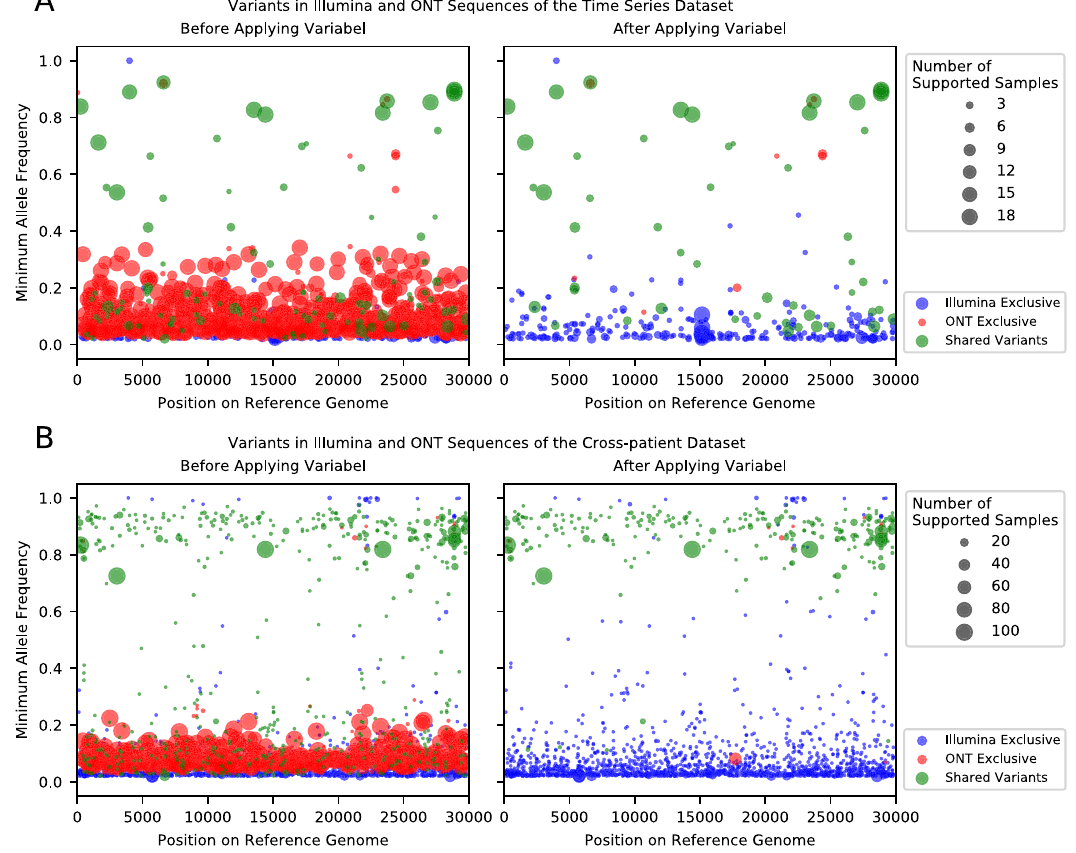
Fig. 2 Variants called by LoFreq with Illumina and ONT sequences before and after applying Variabel for COVID-19 datasets. In each of the sub fi gures, the left plot shows the variant calls before applying variabel and the right plot shows the variant calls after applying variabel. The x -axis shows the position of the variant on the reference genome. The y -axis shows the minimum allele frequency of the variant found in multiple samples. Variants found in the Illumina sequences only are marked in blue, and variants found in the ONT sequences only are marked in red. Variants that are shared between both Illumina and ONT data are shown in green. The size of the dot represents the number of samples supporting the variant. A Variant calls of the time series dataset. B Variant calls of the cross-patient dataset. For both A and B , source data are provided as a Source Data fi